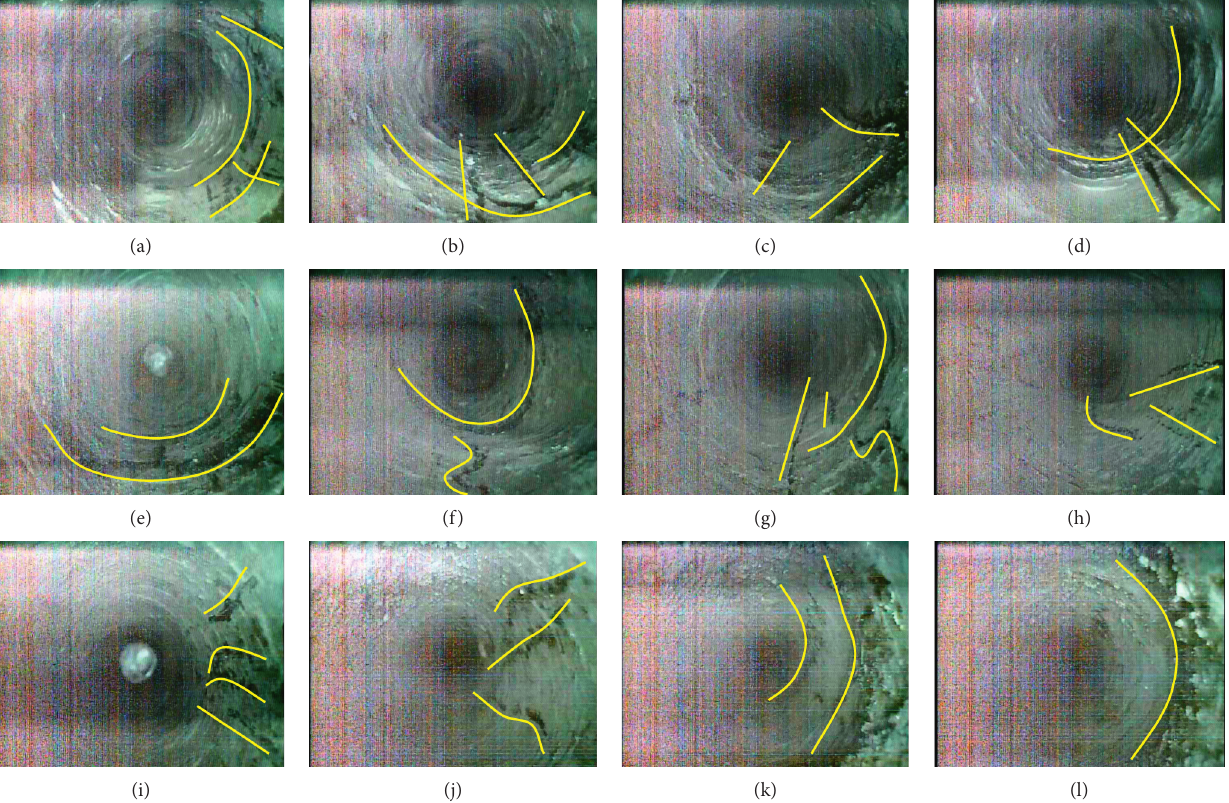
Figure 8: Fracture degree of the surrounding rock around drilling hole. (a) H1-4.0m, (b) H1-2.9 m, (c) H1-1.9 m, (d) H1-1.0m, (e) H2- 4.7m, (f) H2-3.45m, (g) H2-2.44m, (h) H3-1.6 M, (i) H3-4.75 m, (j) H3-2.74m, (k) H3-1.72 m, (l)